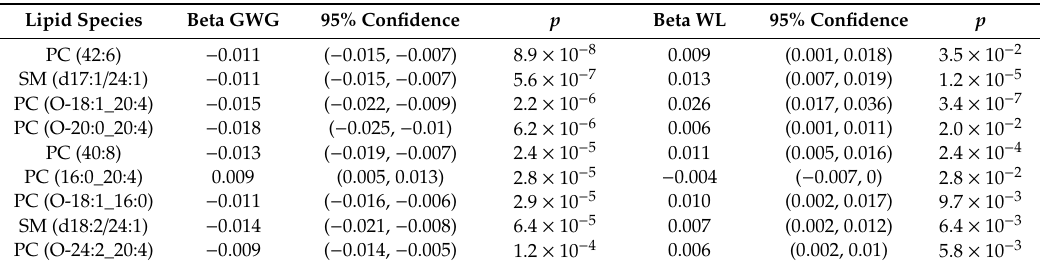
Table 1. Linear regression analysis between lipid level (fractional change), and GWG and WL. Only lipids which were found to be significantly associated with either GWG or WL are shown below ( p threshold = 0.0017). Bonferroni correction is used to account for multiple testing. Lipid Species